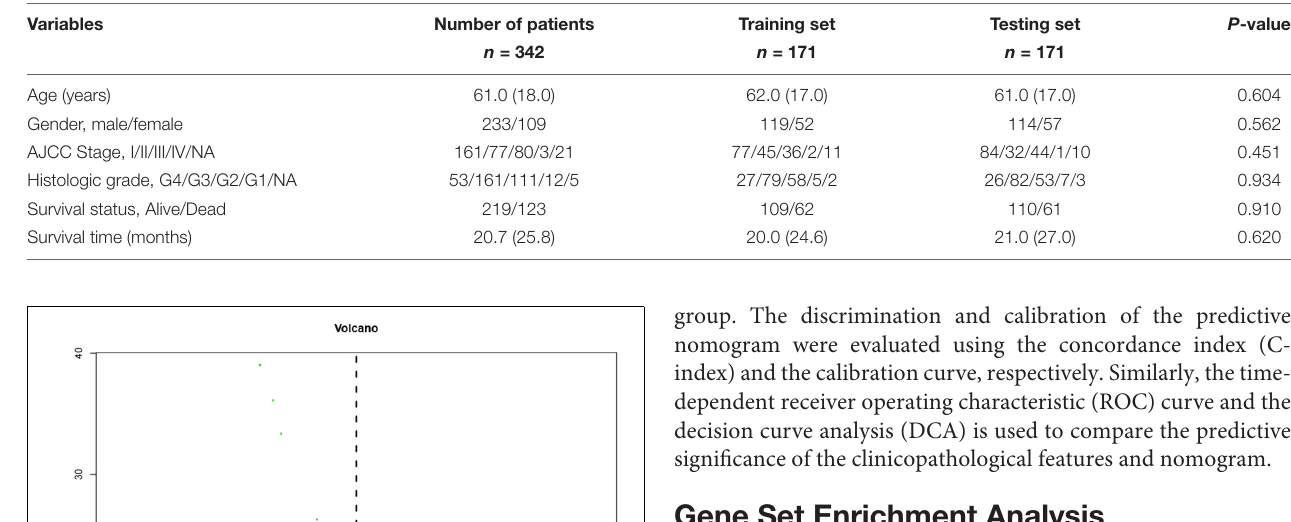
TABLE 1 | Clinical information of the 342 patients with liver cancer.